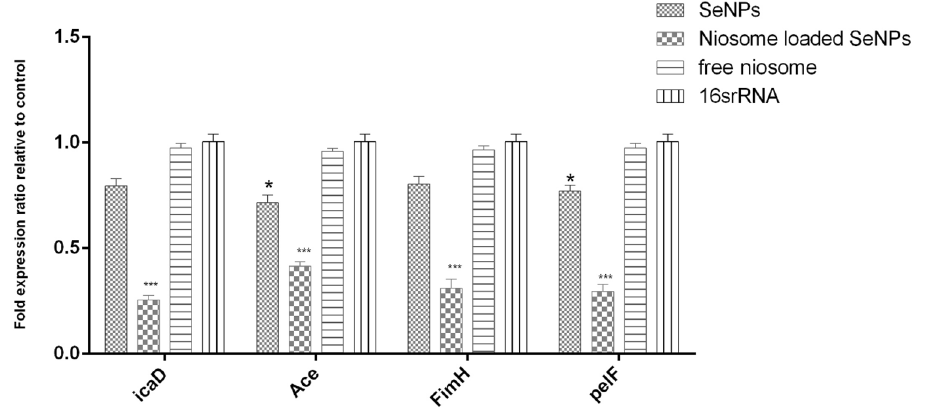
Figure 6. Biofilm-related gene expression analysis after treatment with free SeNPs, free niosome, and niosome loaded SeNPs. n = 3, *** p < 0.0001; ** p < 0.01; * p <